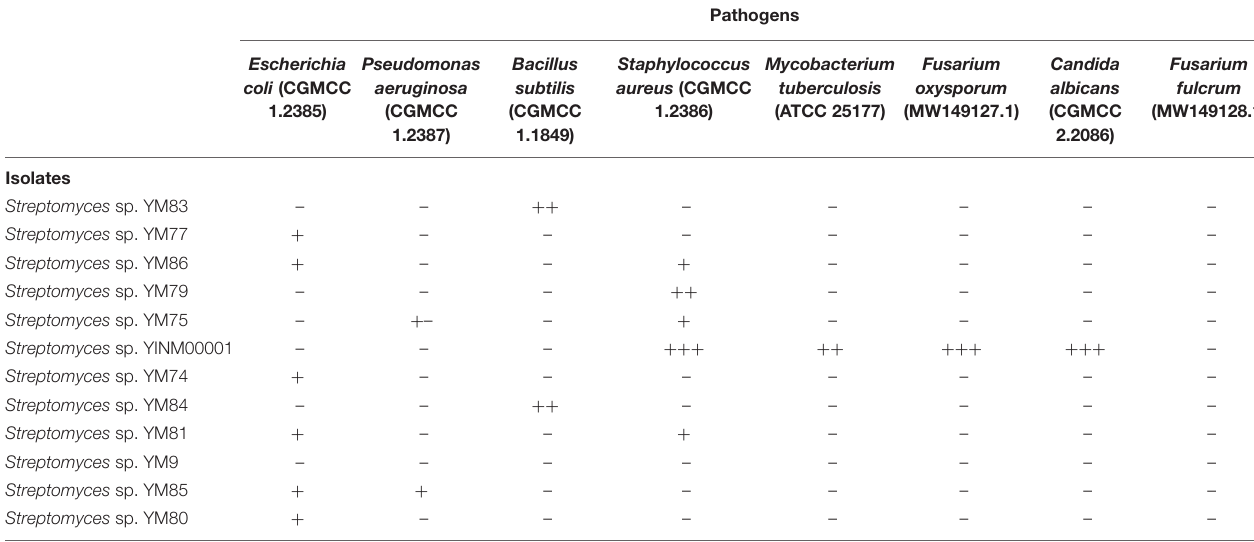
TABLE 1 | Antimicrobial activity assay of Streptomyces strains.